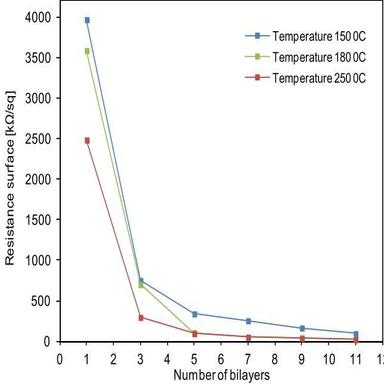
The surface resistance of multilayers films (PEI/rGO)n on flexible polyimide plates after thermal reduction in different temperatures (150 °C, 180 °C, 250 °C).